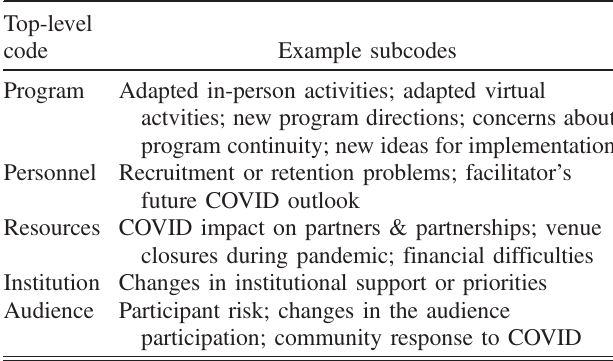
along with a few representative subcodes from each category of top-level code. These codes were articulated